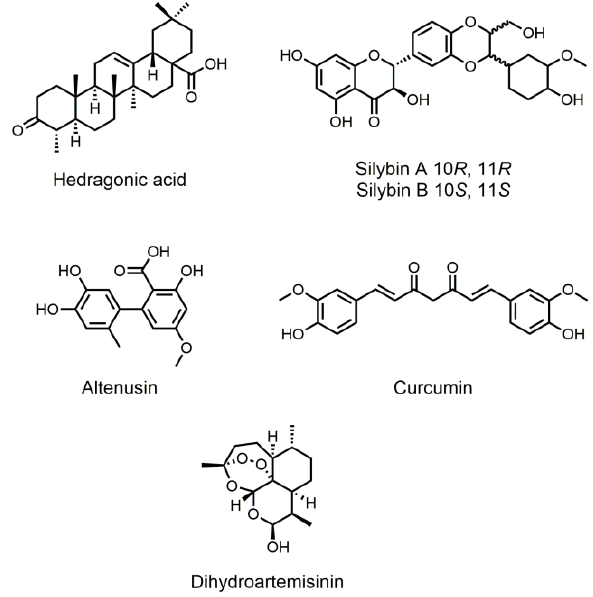
FIGURE 3. Natural FXR